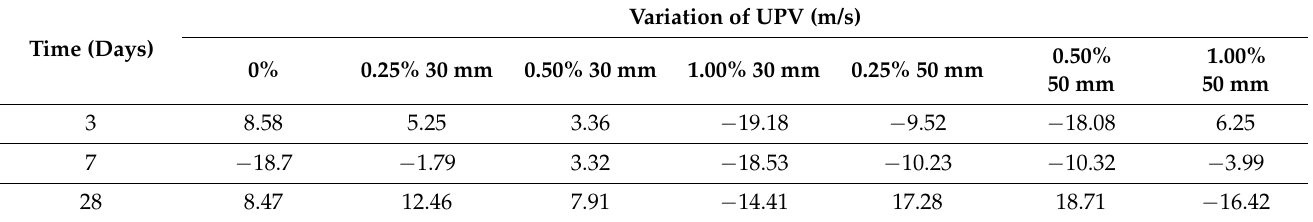
Figure 19. UPV indirect measurements with 200 mm path length. Table 8. Indirect UPV percentage change between 100 mm and 200 mm path Table 7. Indirect UPV for different path lengths at 3, 7, and 28 days (m/s).